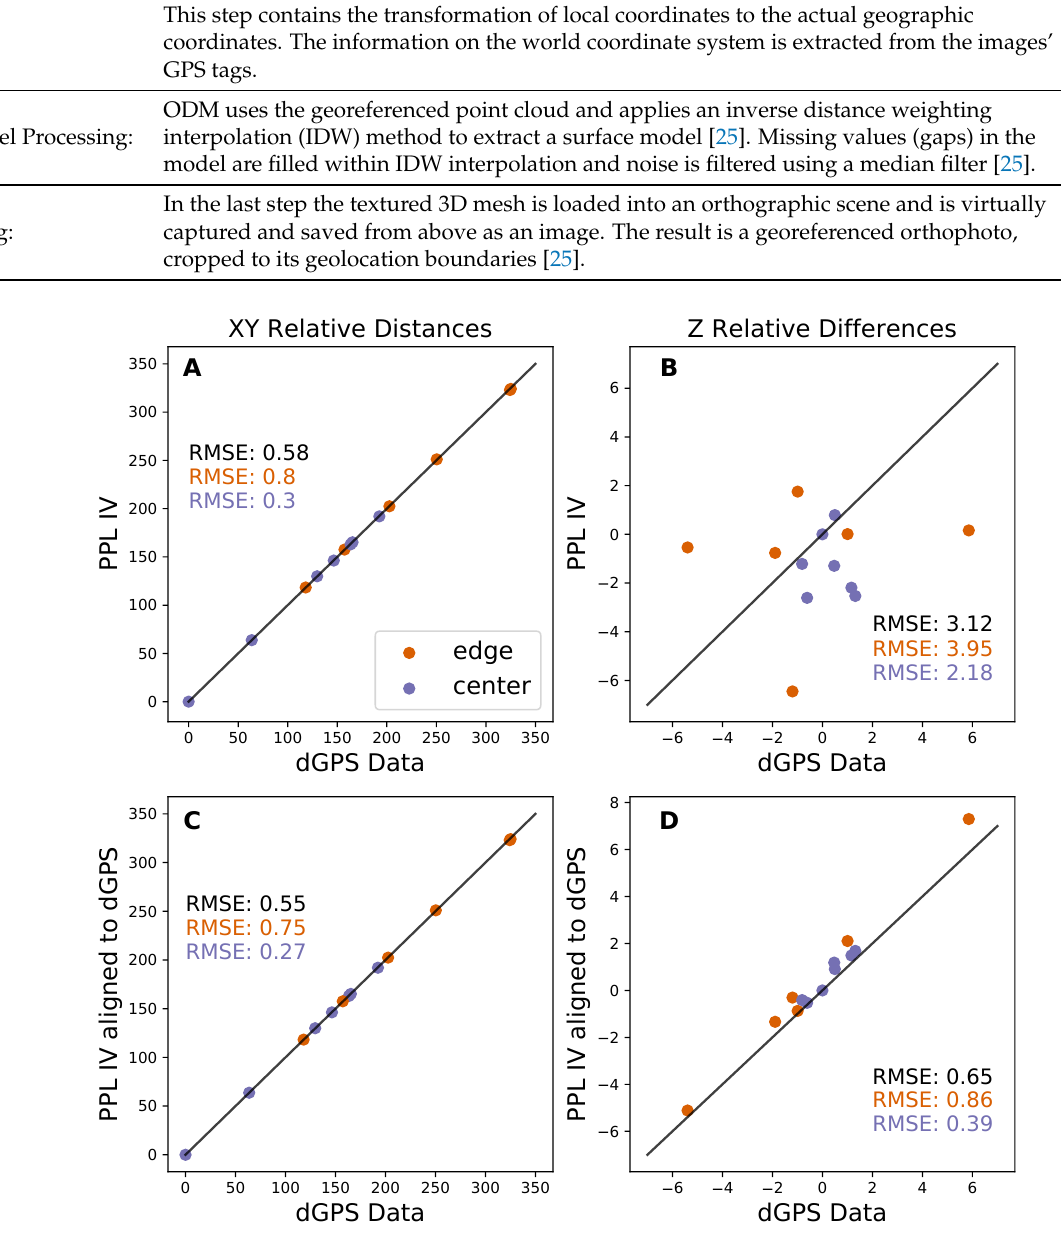
Figure A1. Comparison of relative horizontal distances and vertical differences with the ones of the point cloud at post-processing level IV ( A , B ) and after rotating and translating the point cloud at post-processing level IV with the 2019 transformation matrix ( C , D